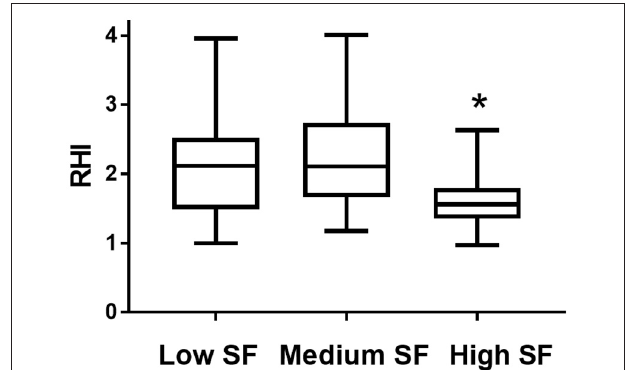
TABLE 3 | Reactive hyperemia index (RHI): multivariate analysis n =